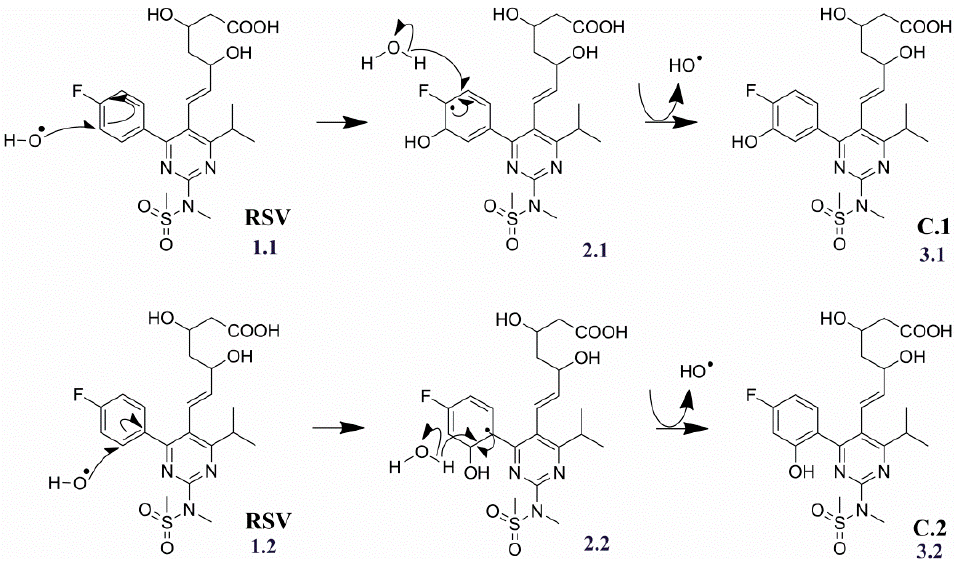
Pharmaceuticals 2021 , 14 , 1160 Scheme 3. Proposed mechanism of the compounds C.1/C.2 formation by radical substitution on RSV. 2.3.4. Degradation Products D.1/D.2 ( m/z 514.1659)